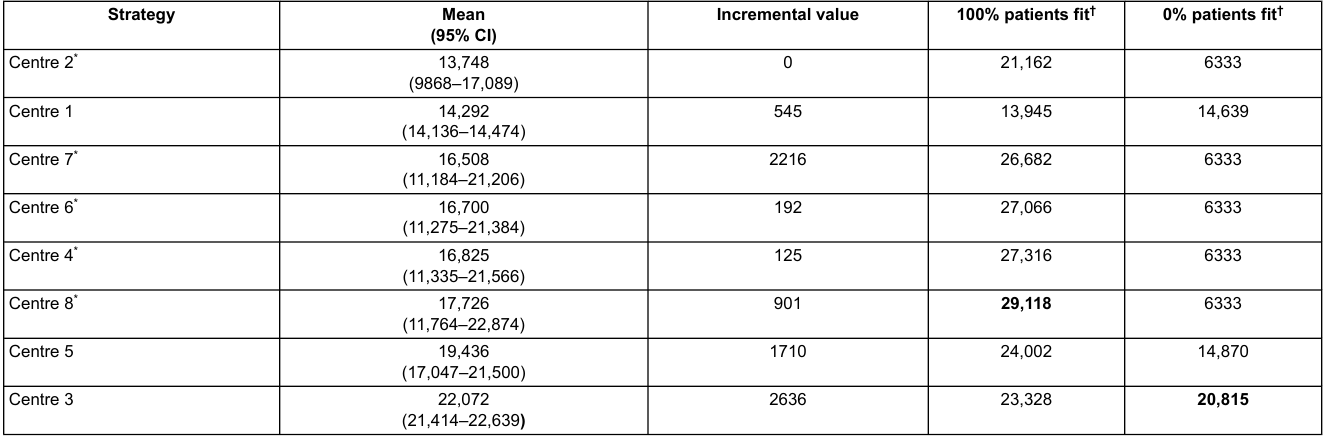
Table 2: Base case mean cost/patient in CHF.